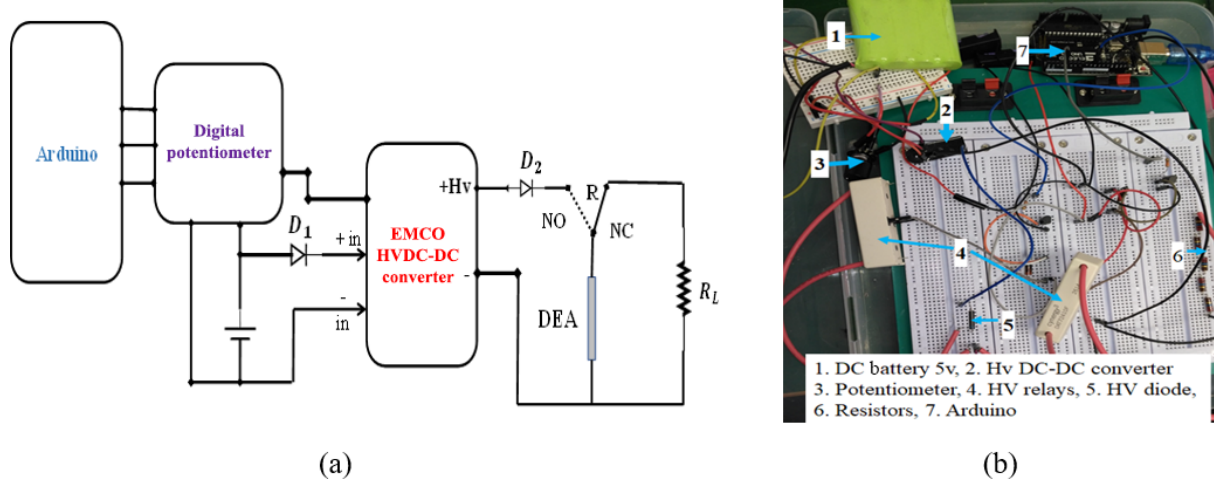
Figure 7. The electric circuit of the DE actuator. (a) The schematic diagram. (b) A photo of the electric circuit.